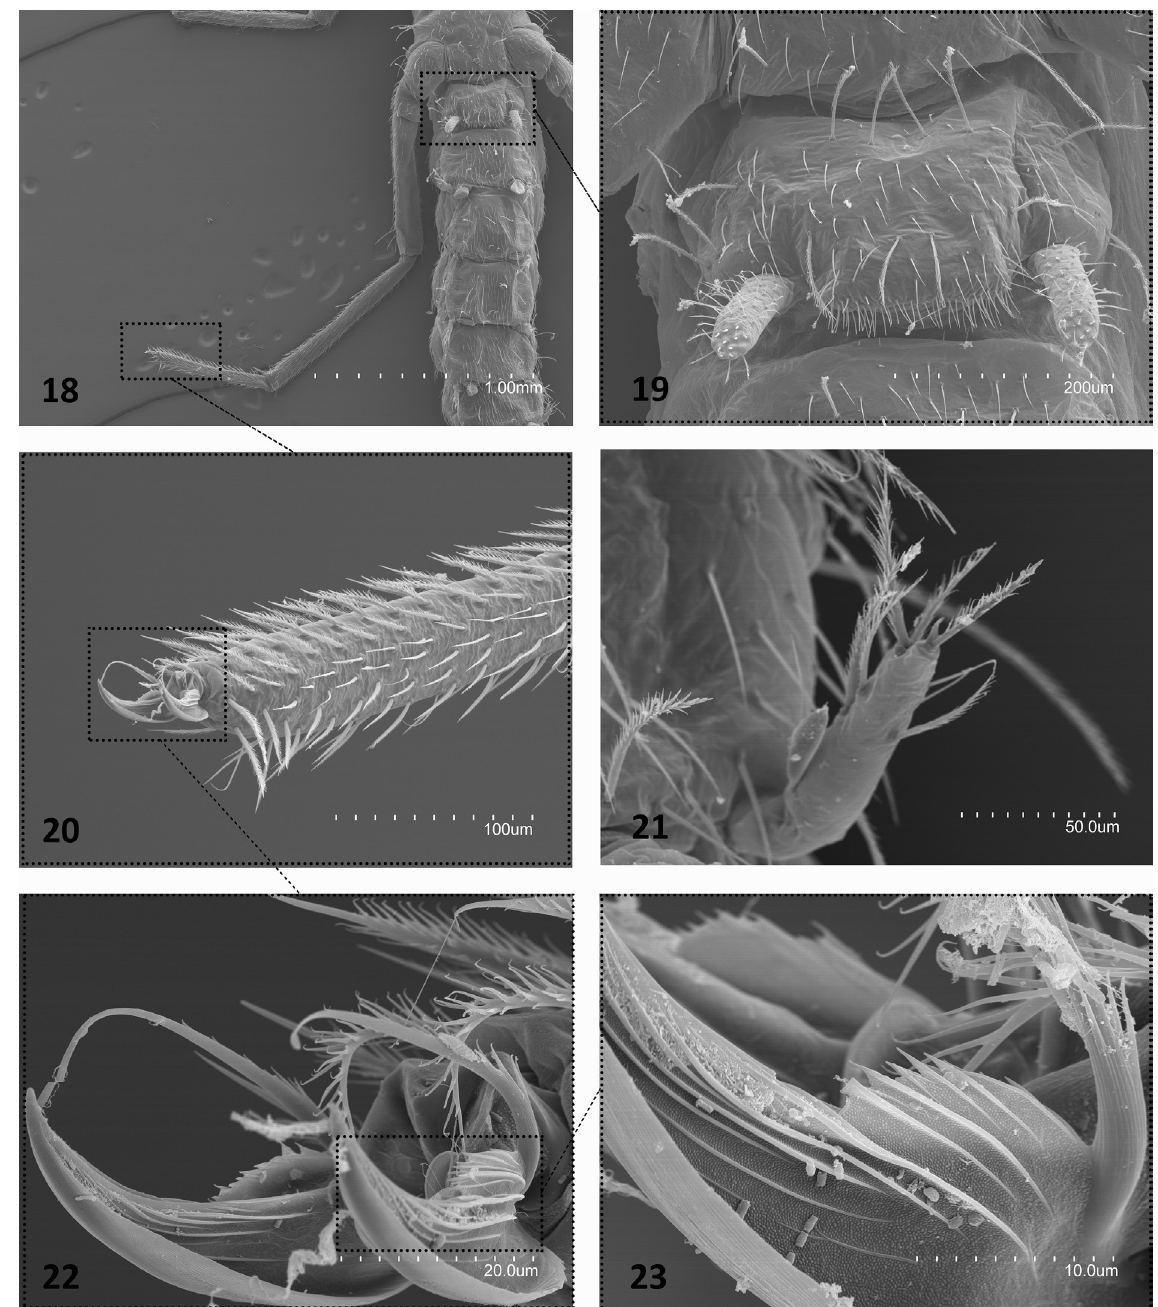
Figs 18–23. Plusiocampa ( Plusiocampa ) baetica Sendra, 2004, from Cueva de Nerja, Nerja,